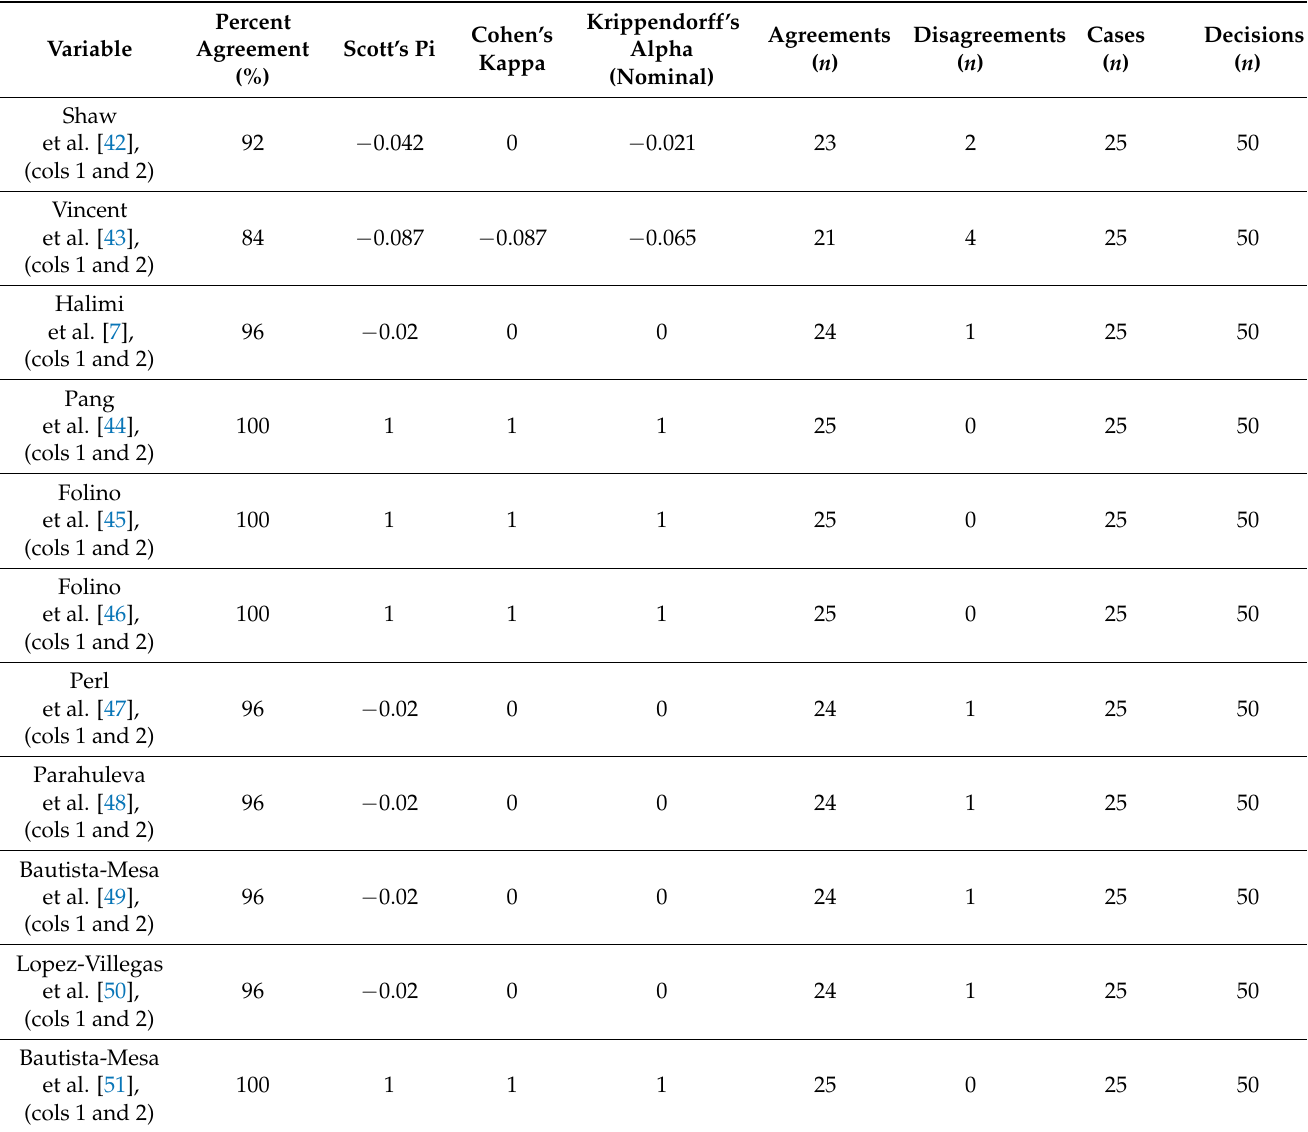
Table 5. Intercoder reliability and